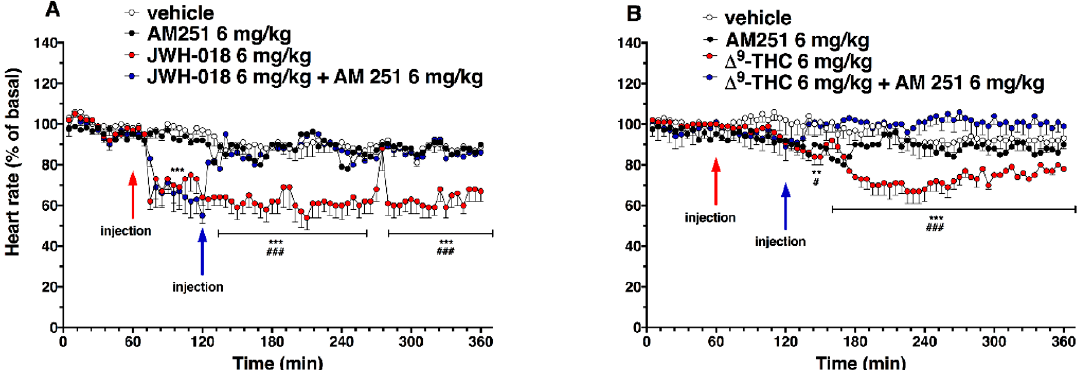
Figure 4. Interaction of JWH-018 (6 mg/kg i.p, panel ( A )) and ∆ 9 -THC (6 mg/kg i.p, panel ( B )) with the selective CB 1 receptor antagonist AM 251 (6 mg/kg, i.p.) on heart rate. Data are expressed as percentage of basal values in the form MEAN ± SEM of 8 different evaluations for each group. Statistical analysis was performed by two-way ANOVA, followed by Bonferroni’s test for multiple comparisons. ** p < 0.01 *** p < 0.001 versus vehicle, and # p < 0.05 ### p < 0.001 versus AM 251 + agonists.